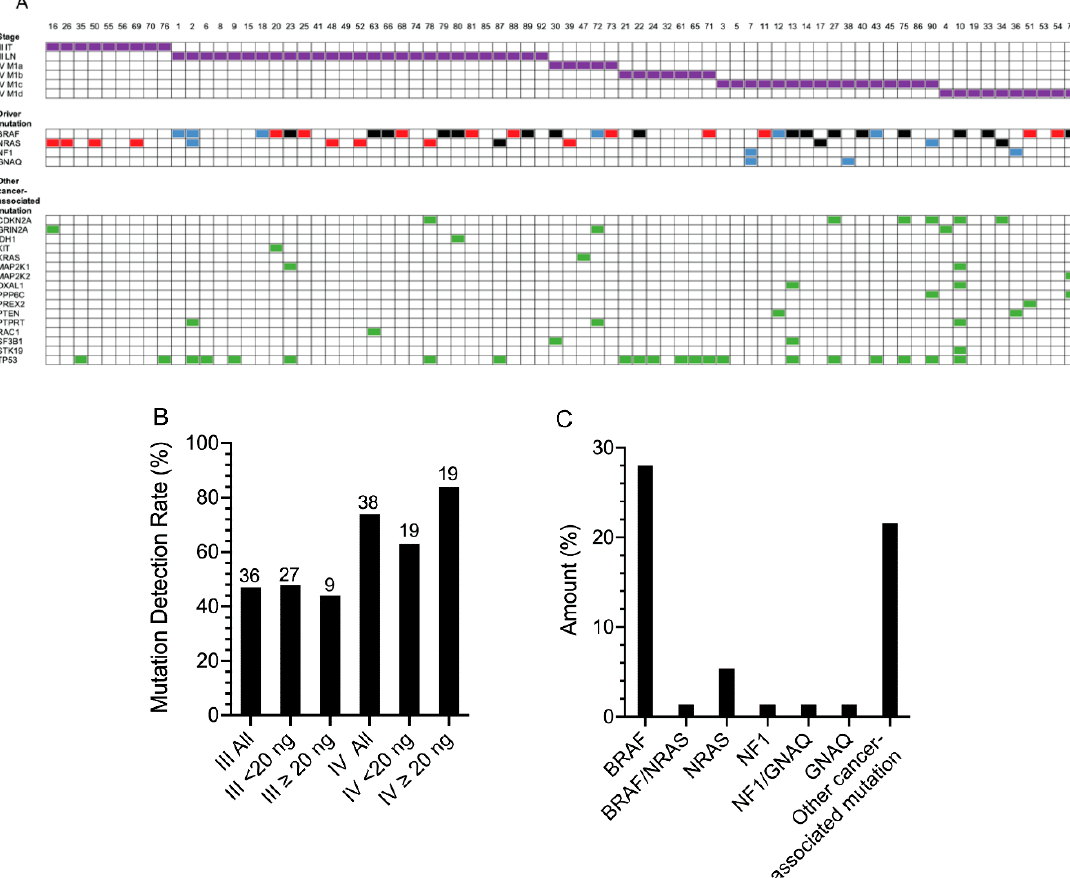
Figure 4. Summary of the melanoma mutation profile and rate of detection based on the custom melanoma panel. ( A ) Comparison of melanoma stage (purple boxes), driver mutation detected by tissue biopsy (red boxes), driver mutation detected by liquid biopsy (blue boxes), driver mutation detected by both liquid and tissue biopsy (black boxes) and other cancer-associated mutations (green boxes) identified across the cohort of 74 melanoma patients. Numbers represent patient sample number. IT, in-transit; LN, lymph node. For details on specific gene mutations and complete NGS data, refer to Tables S5 and S6. ( B ) Comparison of mutation detection rate for melanoma mutations based on the level of cfDNA used for NGS. Total sample number is shown above each histogram. For details on stage, cfDNA input and melanoma driver or other cancer-associated mutation detected, refer to Table S5. ( C ) Distribution of melanoma driver mutation (BRAF, GNAQ, NF1 and NRAS) or other cancer-associated mutation (only including those which lacked a BRAF, GNAQ, NF1 or NRAS driver mutation). Amount indicates percent of total melanoma cohort ( n = 74).